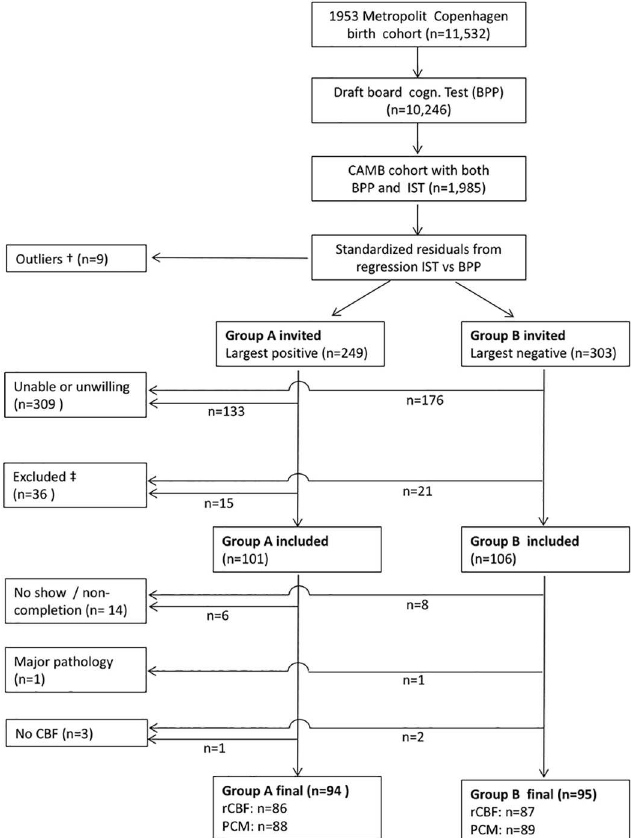
Fig 1. Selection of participants. Flowchart showing selection of the current study sample from the original 1953 Metropolit Copenhagen Birth Chohort. † definedas standardized residualexceeding ± 3 ‡ Excluded accordingto predefinedexclusioncriteria (alcohol and drug abuse, major psychiatric and neurologicdisease, major structural brain lesions, and contraindications to MRI).